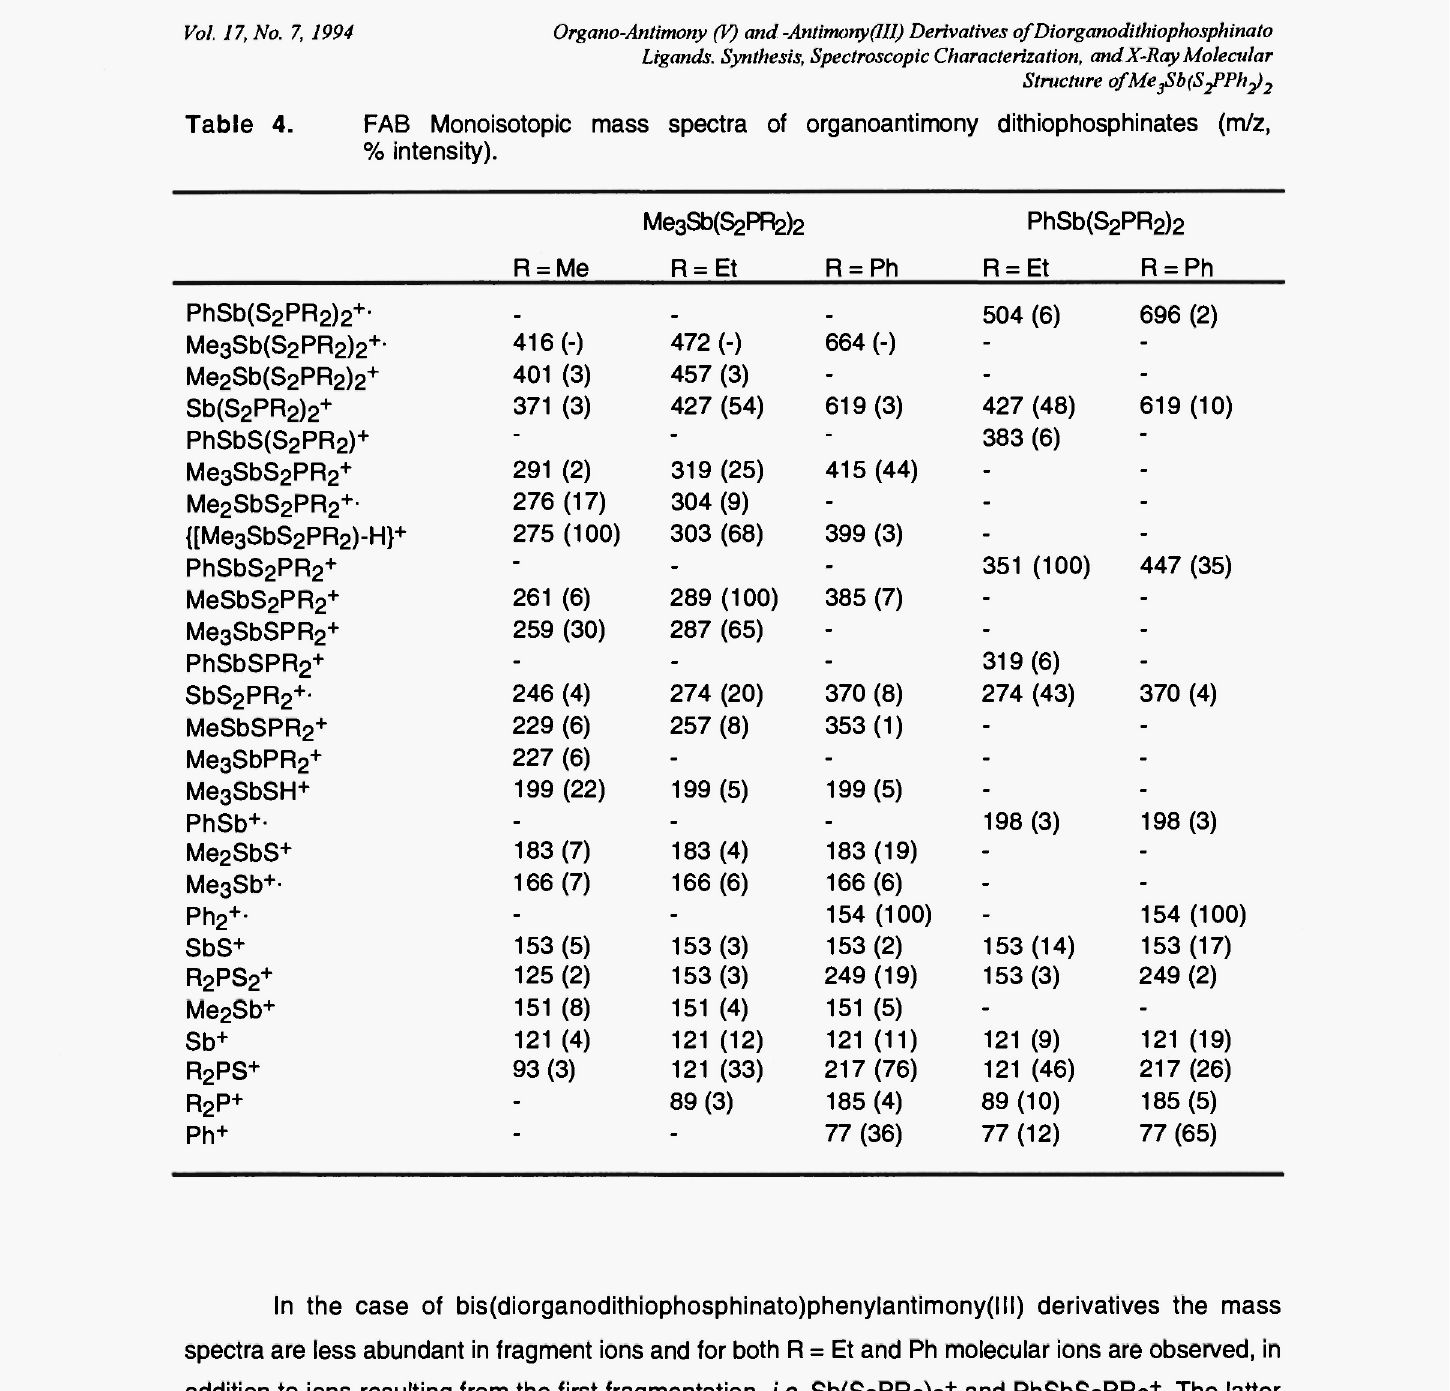
Table 4. FAB Monoisotopic mass spectra of organoantimony dithiophosphinates (m/z, %